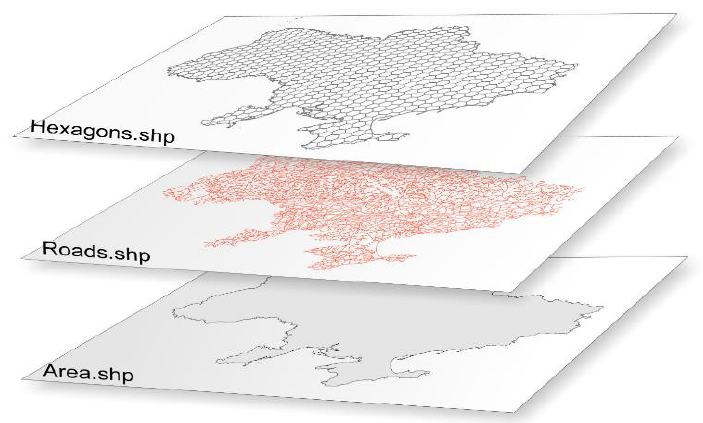
Figure 4. Hexagon polygon shapefile covering the study area.